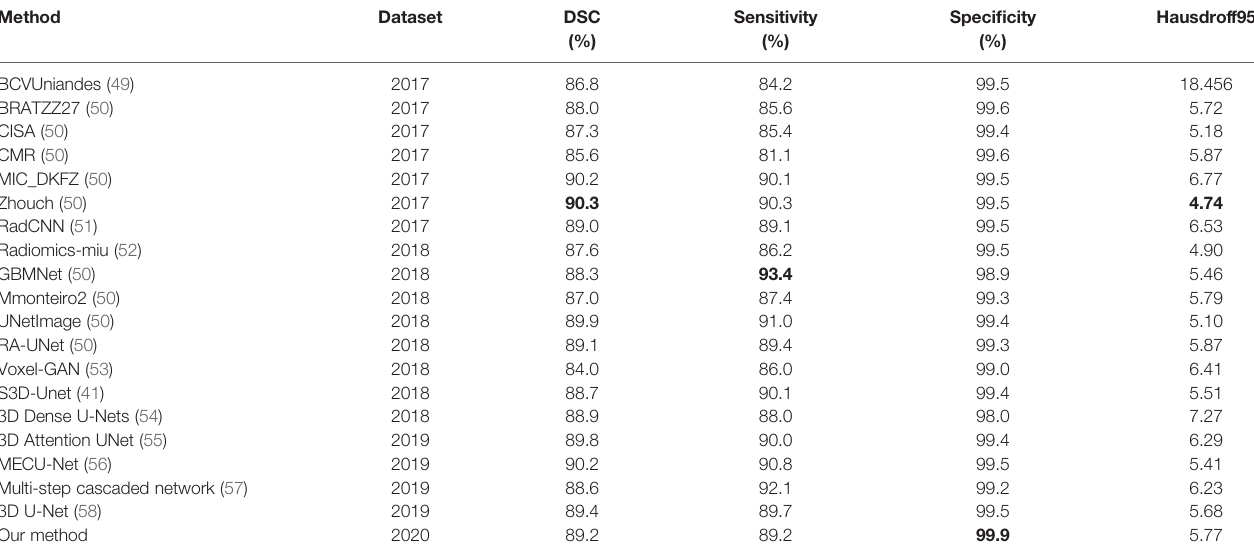
TABLE 5 | The results of comparison between our proposed method and state-of-the-art methods. Method